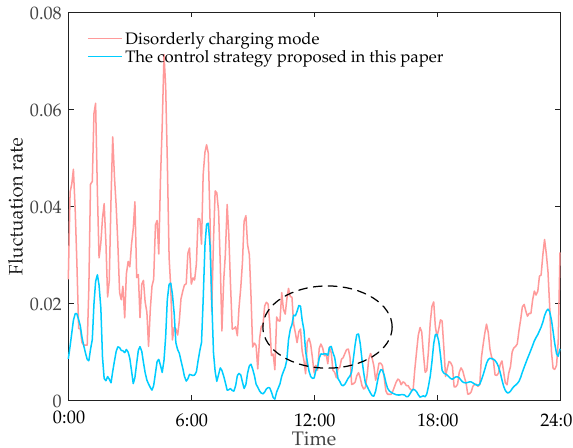
Figure 8. Total load curve.